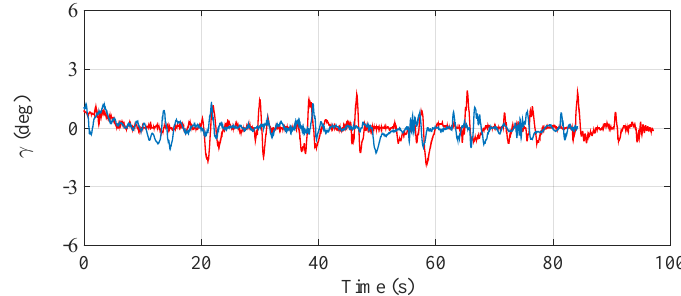
Figure 29. Inclination of the SCMS frame ( γ ) when the optimization is carried out with a α equal to one ( — ) and when the optimization is not considered ( — ).